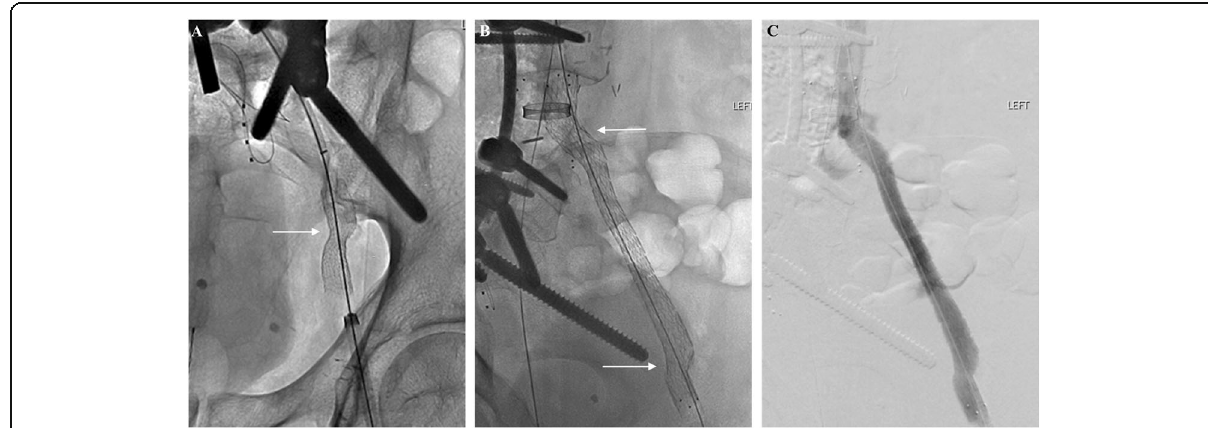
Fig. 3 a Following balloon angioplasty of the LCIV and LEIV, a 13 mm Viabahn endoprosthesis (arrow) was deployed across the site of the extra- vascular connection created; b Additional Venovo stents (arrows) were deployed in the neo-LCIV and LEIV across the Viabahn with extension into the LCFV; c Post-angioplasty venogram showed patency of the left femoral and neo-iliac veins with restoration of normal luminal